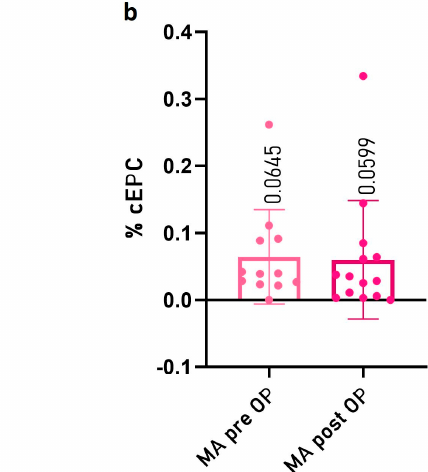
Figure 2. Circulating endothelial progenitor cell (cEPC) in whole blood. ( a ) cEPC levels from a preoperatory set of MMA patients (n = 12) as compared with unrelated controls (UNR, n = 14). ( b ) cEPC levels from a homogeneous group of MMA patients before (pre OP, n = 12) and after (post OP, n = 14) the neurosurgical procedures. Data are expressed as the mean of cEPC% ± SD, where the cEPC% value was calculated as follows: (cEPCs/ µ L/White Blood Cells/ µ L) × 100. Error bars represent mean ± SD. The statistical significance (* p < 0.05) was calculated using two-tailed Student’s t -test ( p =